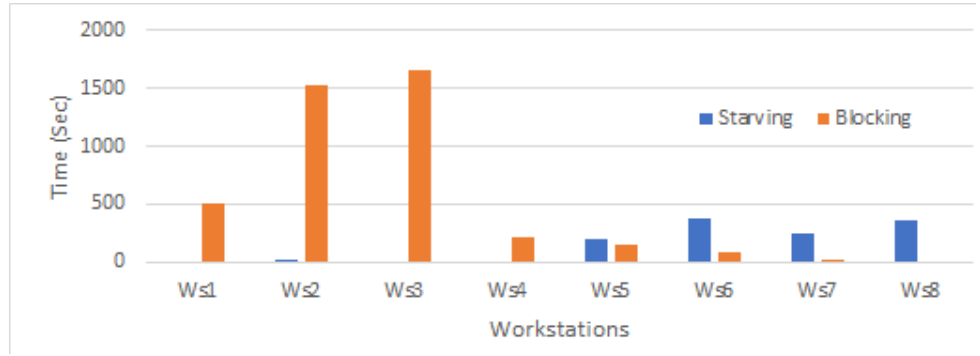
Figure 14. Starving and blocking times for each